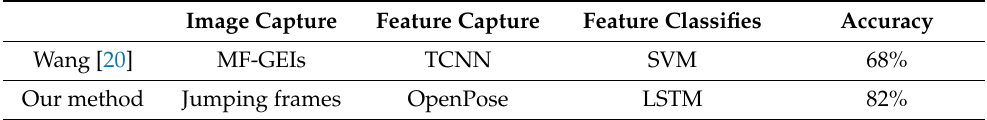
Table 3. Comparison of Wang [20] to our